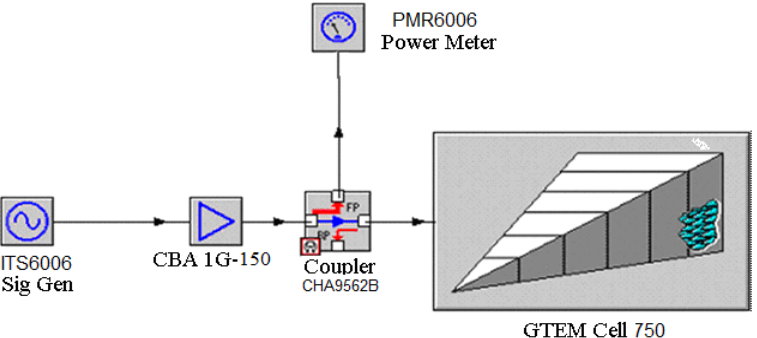
Figure 17. Configuration of equipment used for immunity tests.